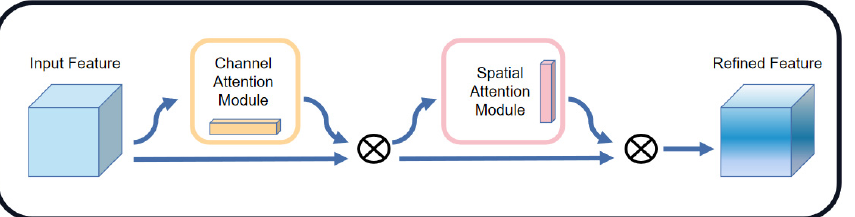
Figure 4. Structure of the CBAM module for implementing both spatial and channel attention mechanisms in feedforward convolutional neural networks.